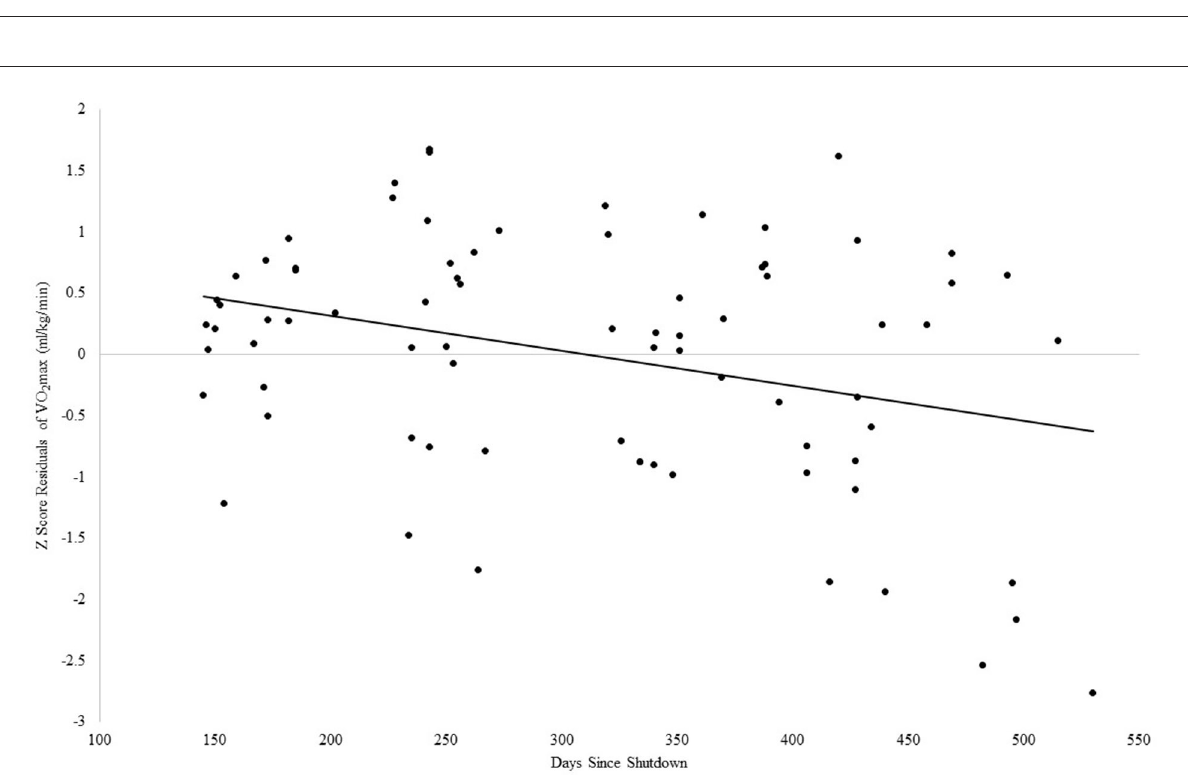
FIGURE4 Association between days since COVID-19 shutdown and VO 2 max in